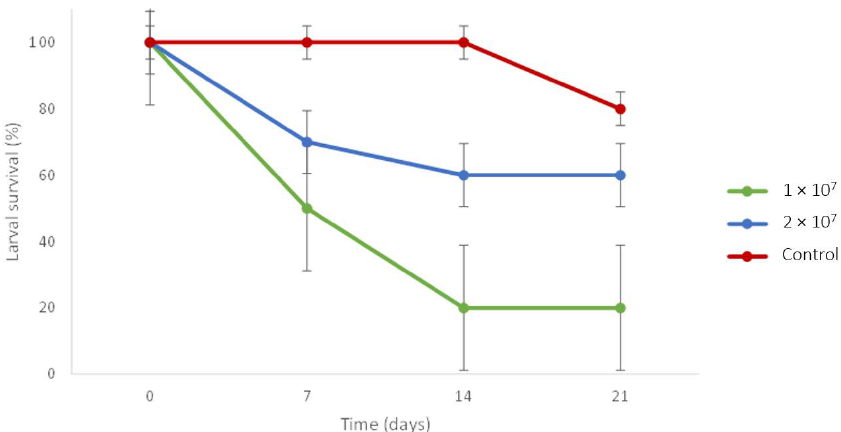
Figure 3. Percentage of larvae surviving infection by M. pinghaense at two di ff erent concentrations. Data is shown with